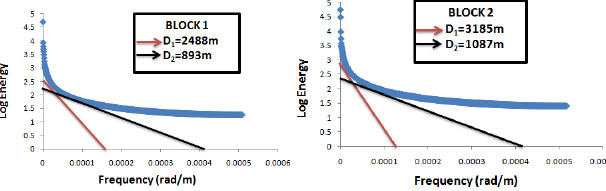
Figure 8: Spectral plots of logarithm of Energy against Frequency (radian per meter).